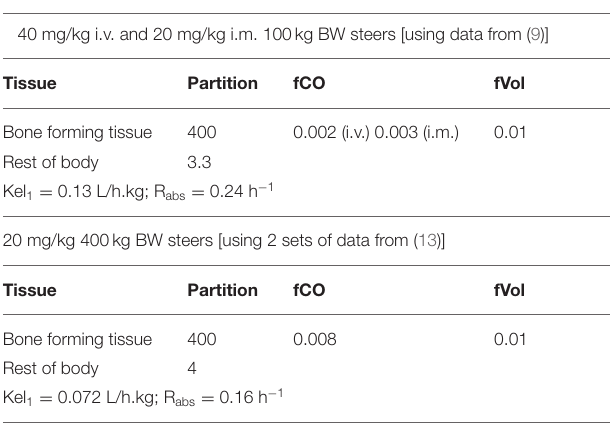
TABLE 4 | Final values of the parameters for 100kg BW and 400kg BW